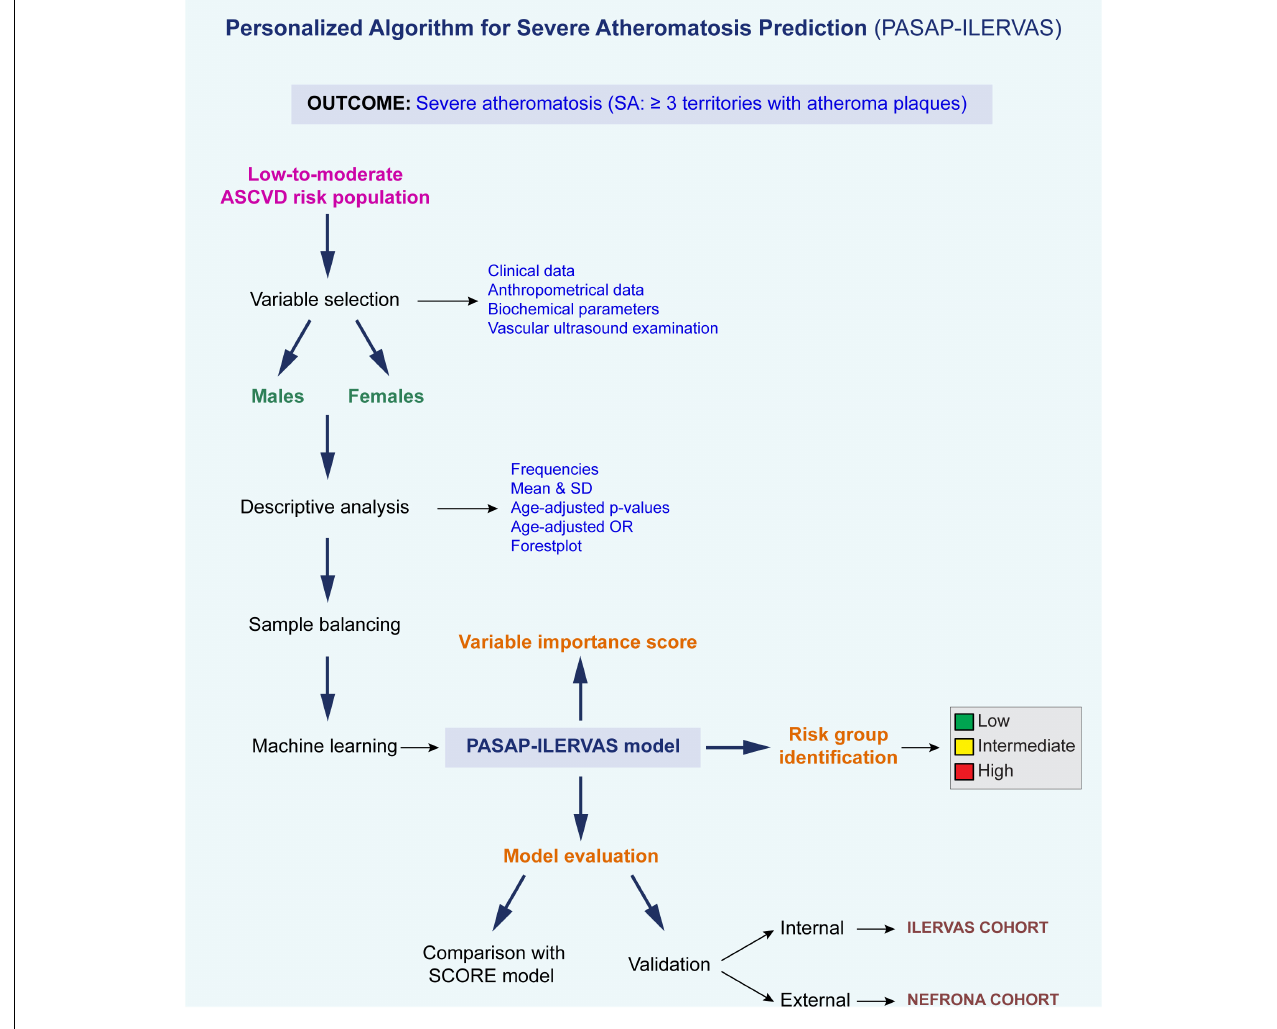
FIGURE 1 | Analysis pipeline. ASCVD, atherosclerotic cardiovascular disease; OR, odds ratio; SD , standard deviation.